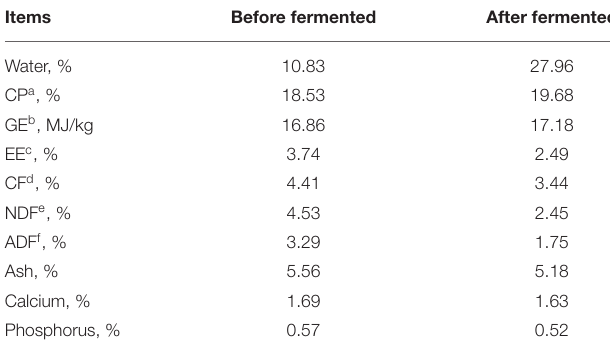
TABLE 3 | Nutrient levels in before and after fermentation.